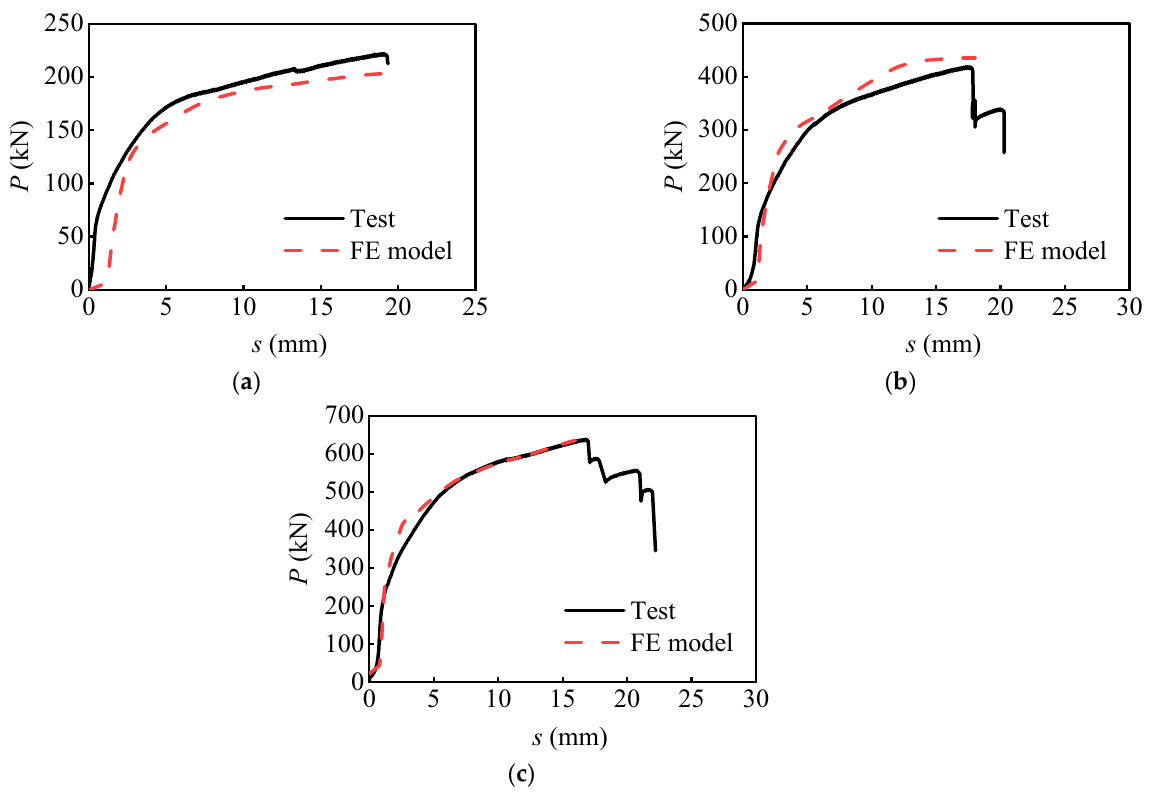
Figure 6. Comparison of the numerical and experimental results: ( a ) SS1; ( b ) DS5; ( c ) TS4.